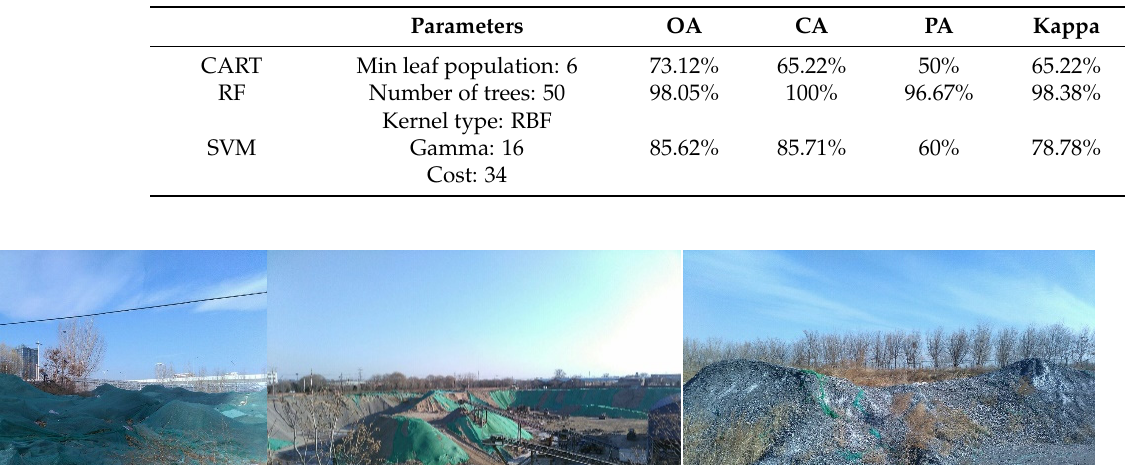
13 of 18 Table 3. Statistics of optimal parameters and accuracy of various algorithms. OA: overall accuracy; CA: consumer accu- racy; PA: producer accuracy; RBF: radial basis function. Parameters